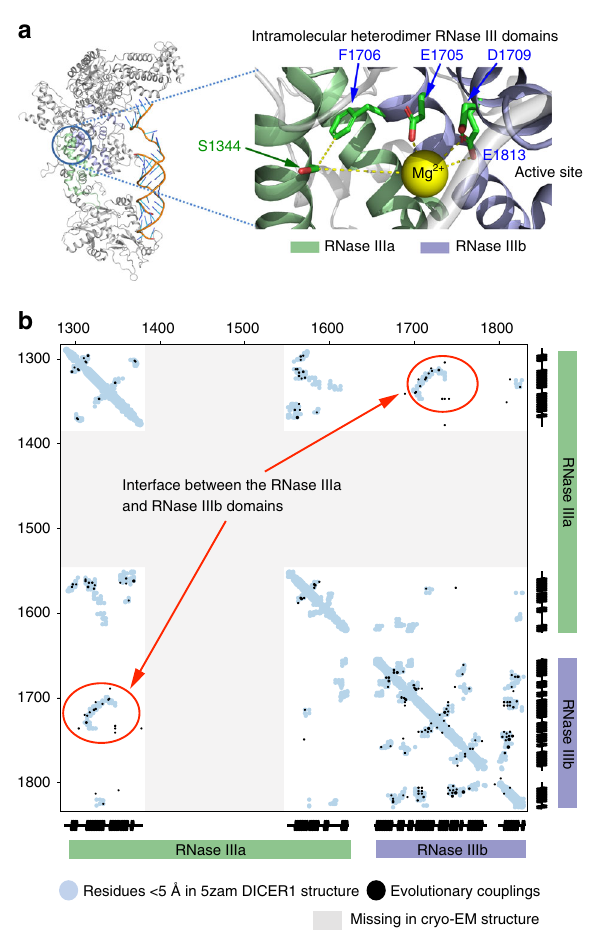
Fig. 5 Structural rationale for how RNase IIIa-S1344 affects RNase IIIb